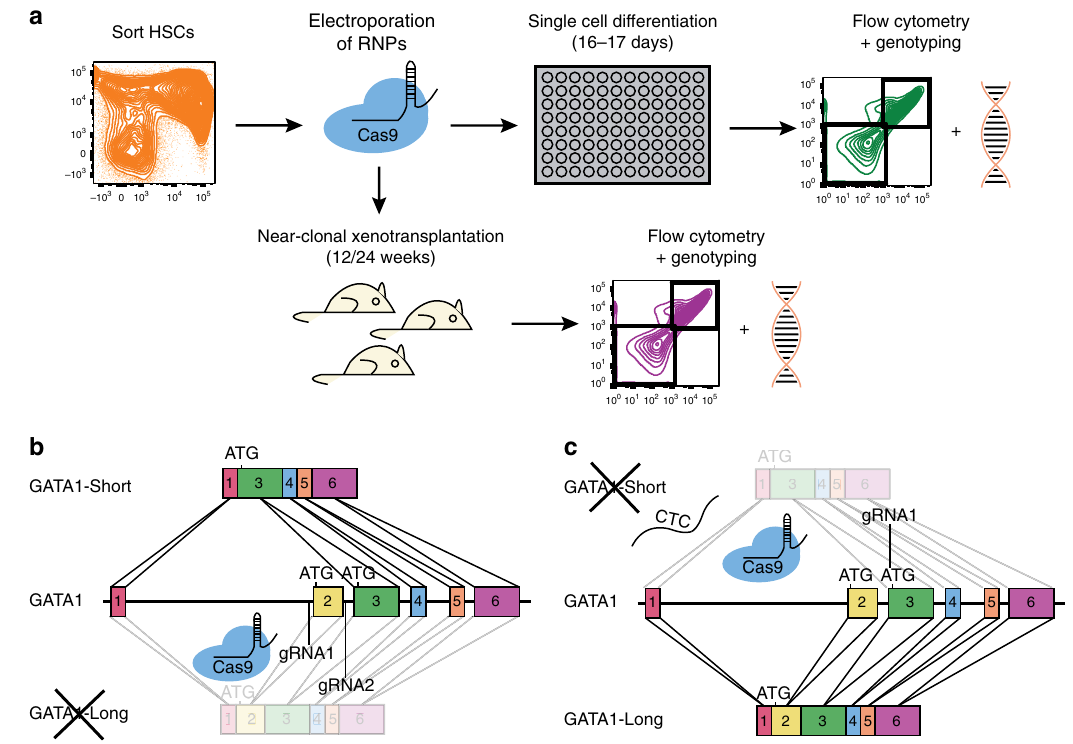
Fig. 1 CRISPR/Cas9-mediated isoform expression of GATA1 at single cell level. a Experimental work fl ow for single cell in vitro differentiation assay and near-clonal xenotransplantation into mice. b Two gRNAs targeting the 5 ′ and 3 ′ end of exon 2 of GATA1 led to the NHEJ-mediated dropout of this exon, resulting in the exclusive expression of GATA1-Short. c HDR-mediated mutation of the alternative start site from ATG to CTC using a single gRNA and a single-strand DNA template, resulting in the exclusive expression of